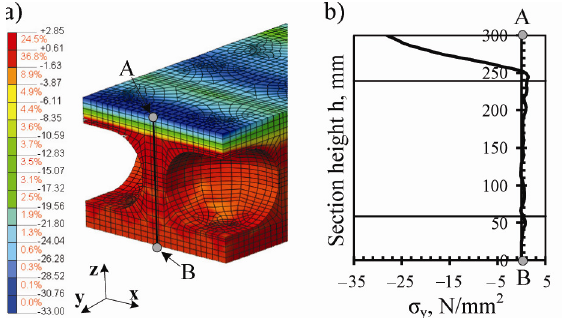
Fig. 14. Stress distribution in the concrete of the slab cross- section, point 3: a) overall image; b) graphic